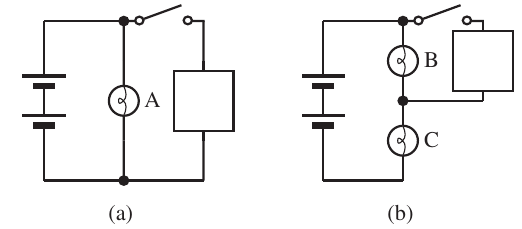
FIG. 7. Parallel connections (a) directly across the battery, (b) in series with another circuit element. The boxes represent any arrangement of bulbs and batteries.